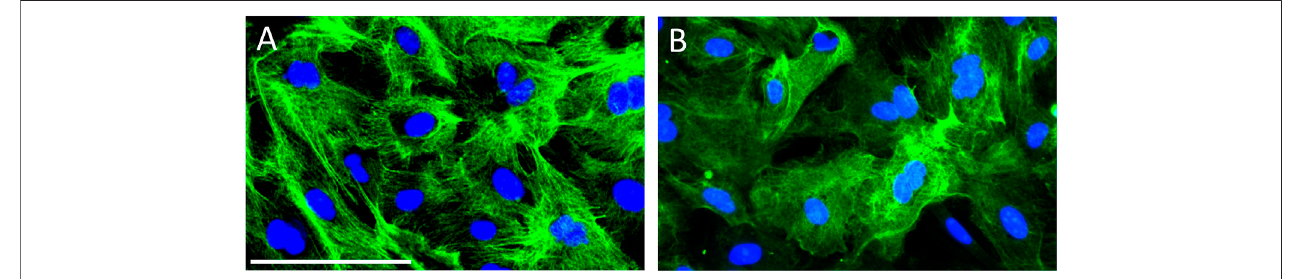
FIGURE 1 | Immunocytochemistry on porcine primary cultured urothelial cells. (A) All cultured cells uniformly expressed AE1/AE3 cytokeratin, the epithelial cell marker, indicating the pure identity of cultured porcine urothelial cells. (B) Cultured urothelial cells show an intense expression of P2X7R in the cytoplasm and membranes. The green color denotes AE/AE3 staining in panel A and P2X7R staining in panel B. The blue color shows the nuclei stained with DAPI. Magni fi cation bar shows 50 µm.